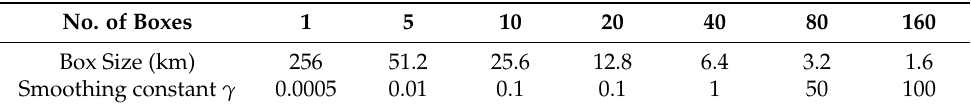
Table 1. Parameters adopted in